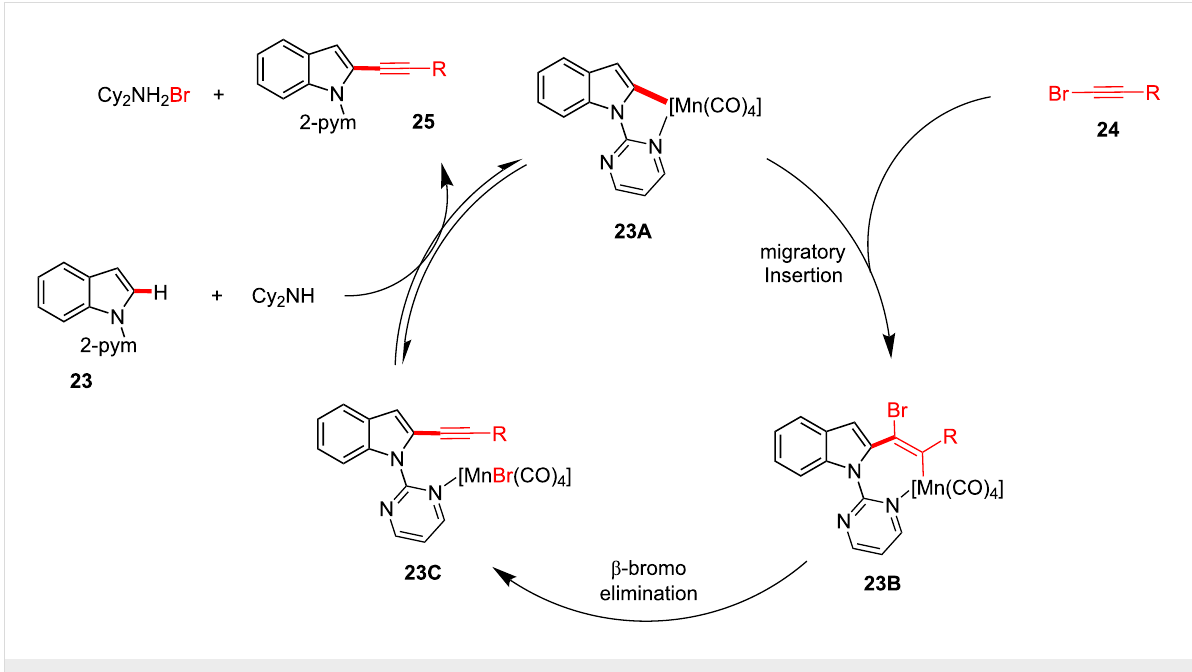
Figure 7: Proposed reaction mechanism of Mn(I)-catalyzed C–H